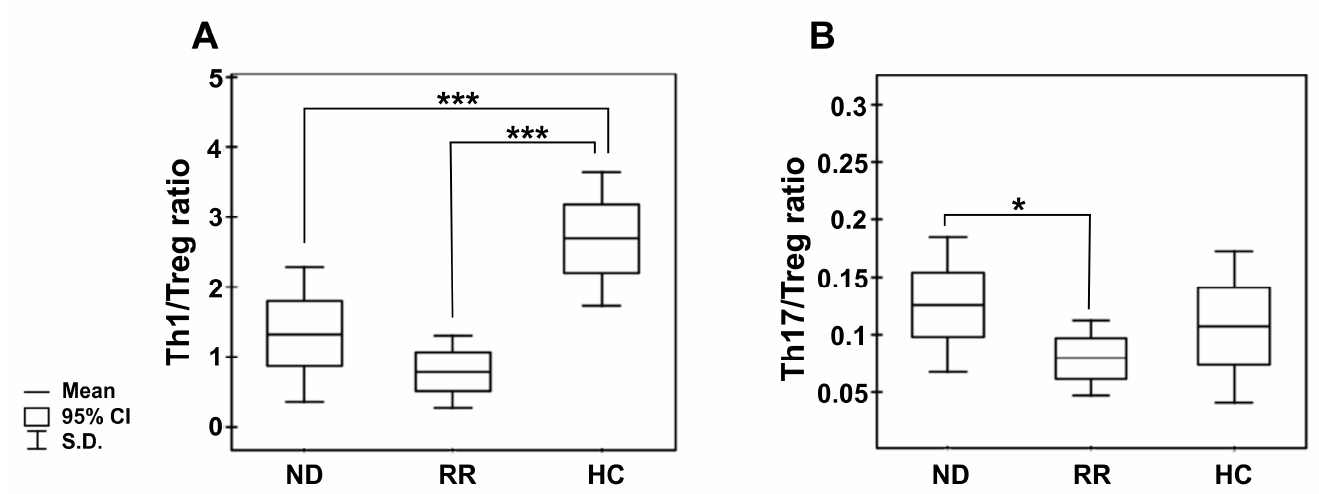
(a) NDMM vs. RRMM; (b) NDMM vs. HC; (c) RRMM vs. HC; *—trend; ns—not statistically significant. Differences in Th1, Th17, and Treg cell subsets between examined groups were evaluated using nonparametric tests (Kruskal-Wallis and Mann-Whitney U-test).